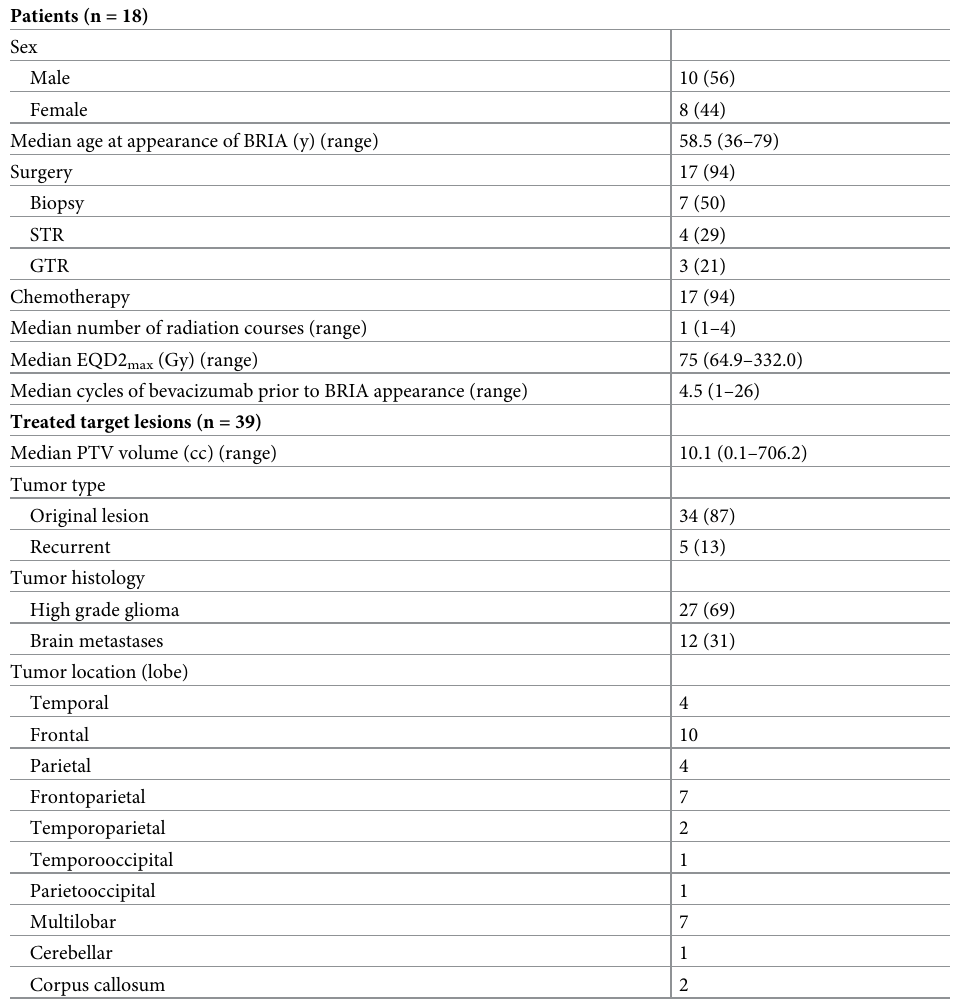
Table 1. Patient, tumor, and treatment